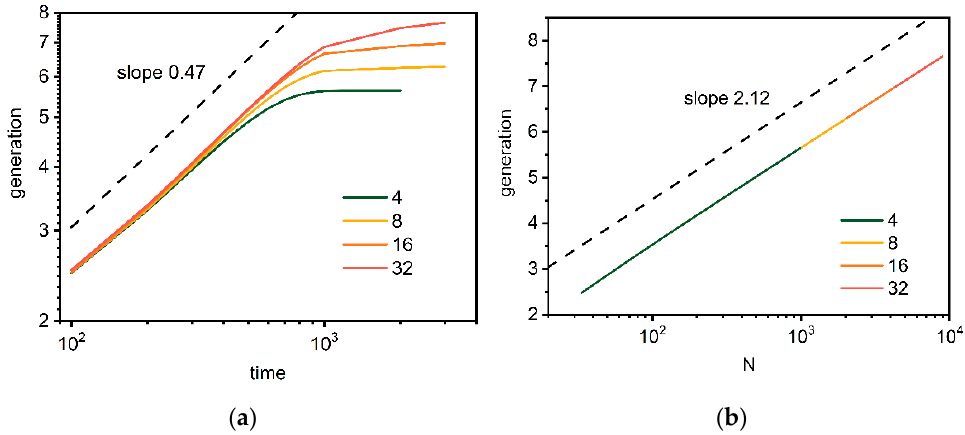
Figure 11. The number of dendrimer generations g as a function of time ( a ) and total number of beads N ( b ). The color indicates the number of macromolecules in the system (see text for details).